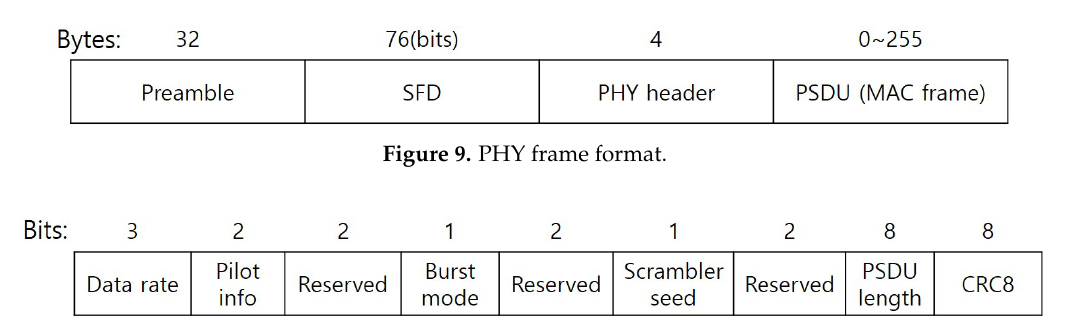
Figure 10. PHY Header